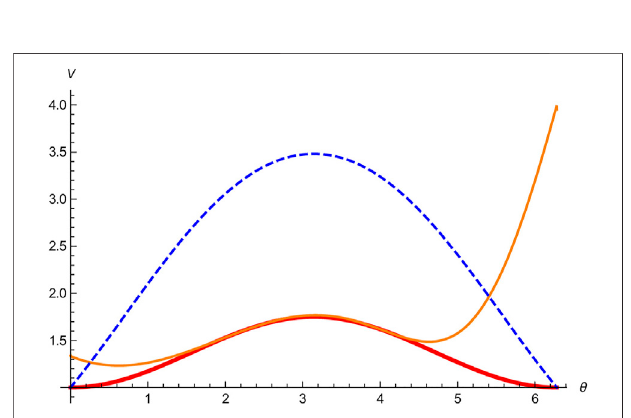
FIGURE 1 | Lower bounds of V ( A ) V ( B ) for a family of spin-1 particles | Ψ ( θ ) 〉 : the product-form uncertainty relation V ( A ) V ( B ),the bound L 1 of Eq. 12 , the bound of Ref. [34], and the bound of Schrödinger uncertainty relation [5] are depicted in red, blue, green, and orange respectively.